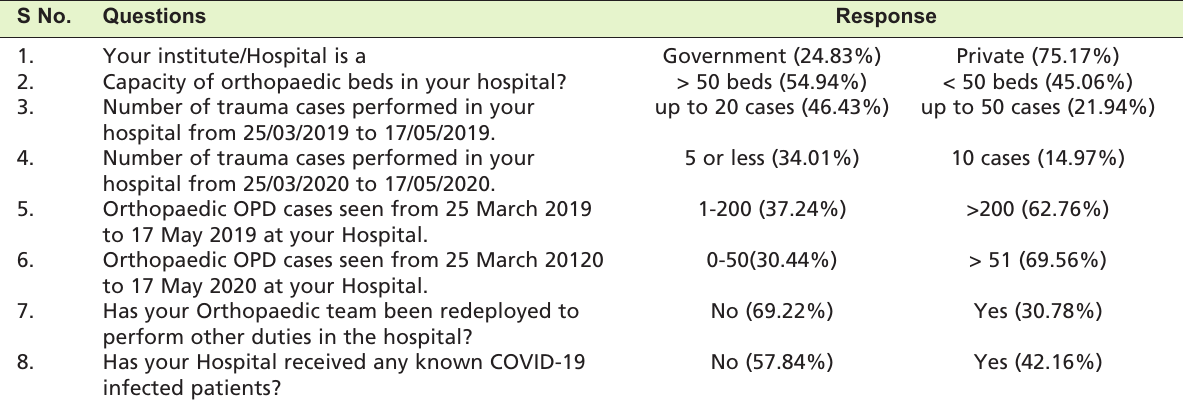
Responses by orthopaedic surgeons Table II: